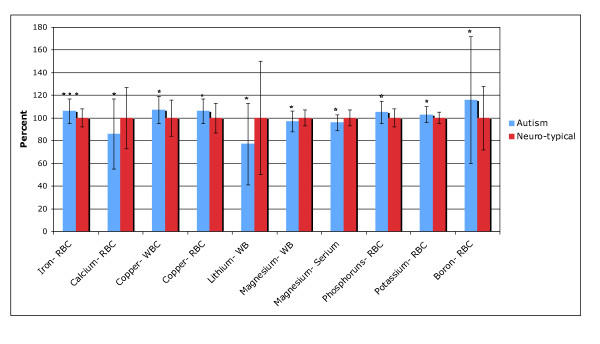
Minerals which were significantly different between the autism and neurotypical groups, rescaled to the average neurotypical values. The average values and the standard deviations are shown. The number of asterisks indicates the p-value (* p < 0.05, ** p < 0.01, *** p < 0.001).